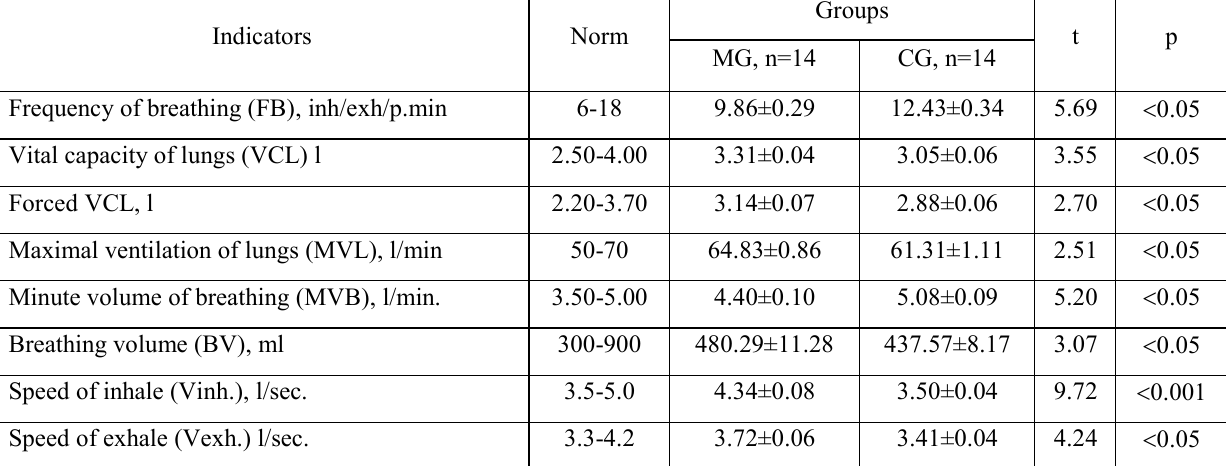
Spirographic indicators of main and control groups’ patients, received at repeated examination (М  m) Indicators